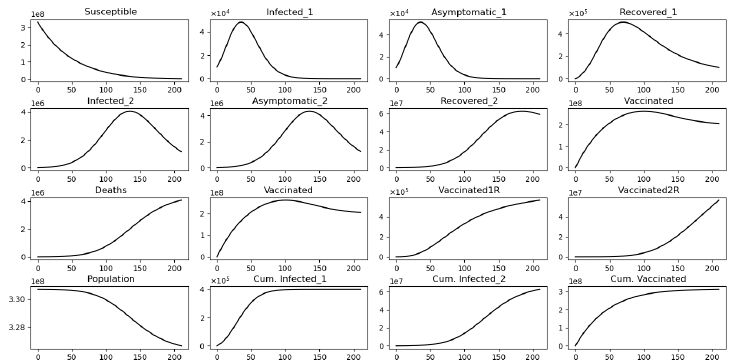
≈ 0.95 > R ≈ 0.87. The 0 1 2 1